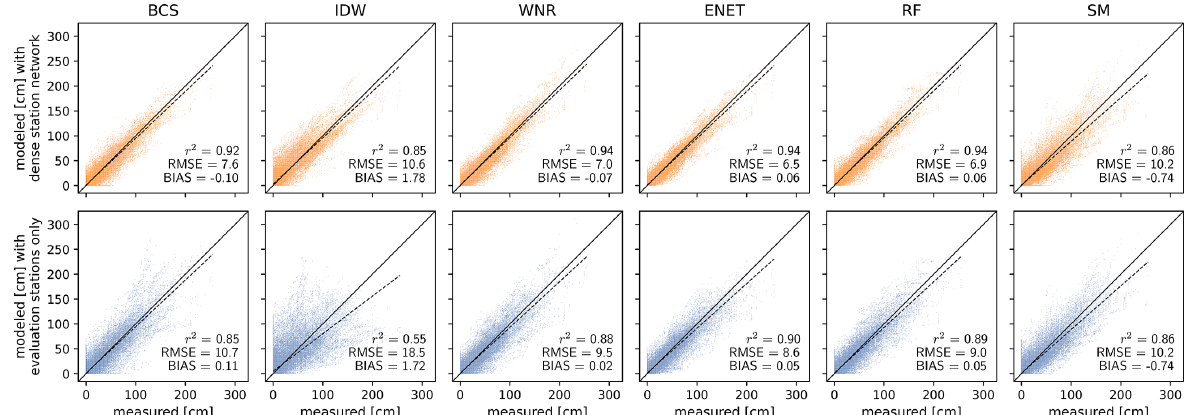
Figure 3. Reconstructed daily snow depth values plotted against the measured values for the methods used (columns). Data in the top row are calculated in the full station network, and data in the bottom row are calculated using the evaluation stations only. The solid black line represents perfect predictions, and the dashed line is a linear fit of predicted versus measured values. The three score metrics coefficient of determination ( r 2 ), root mean squared error (RMSE) and bias are indicated in each panel.